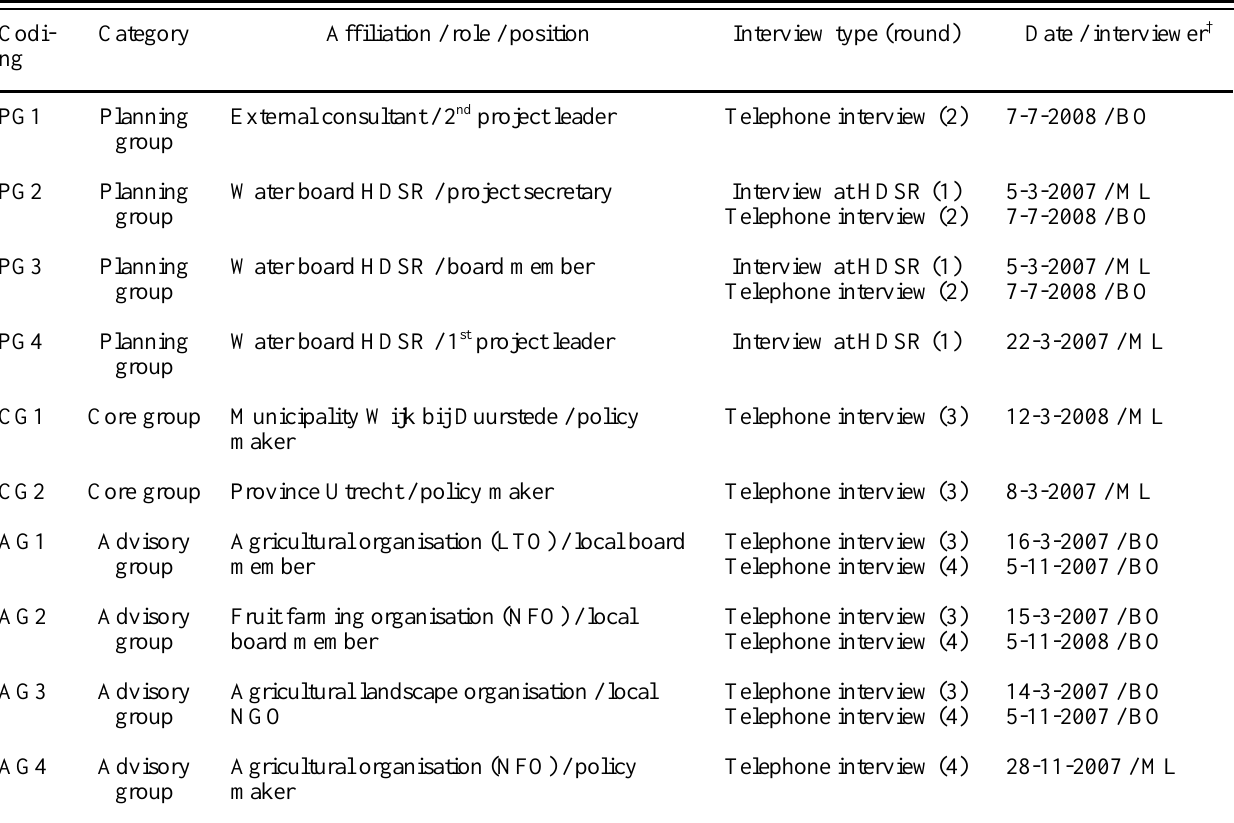
Table 3. Coding of